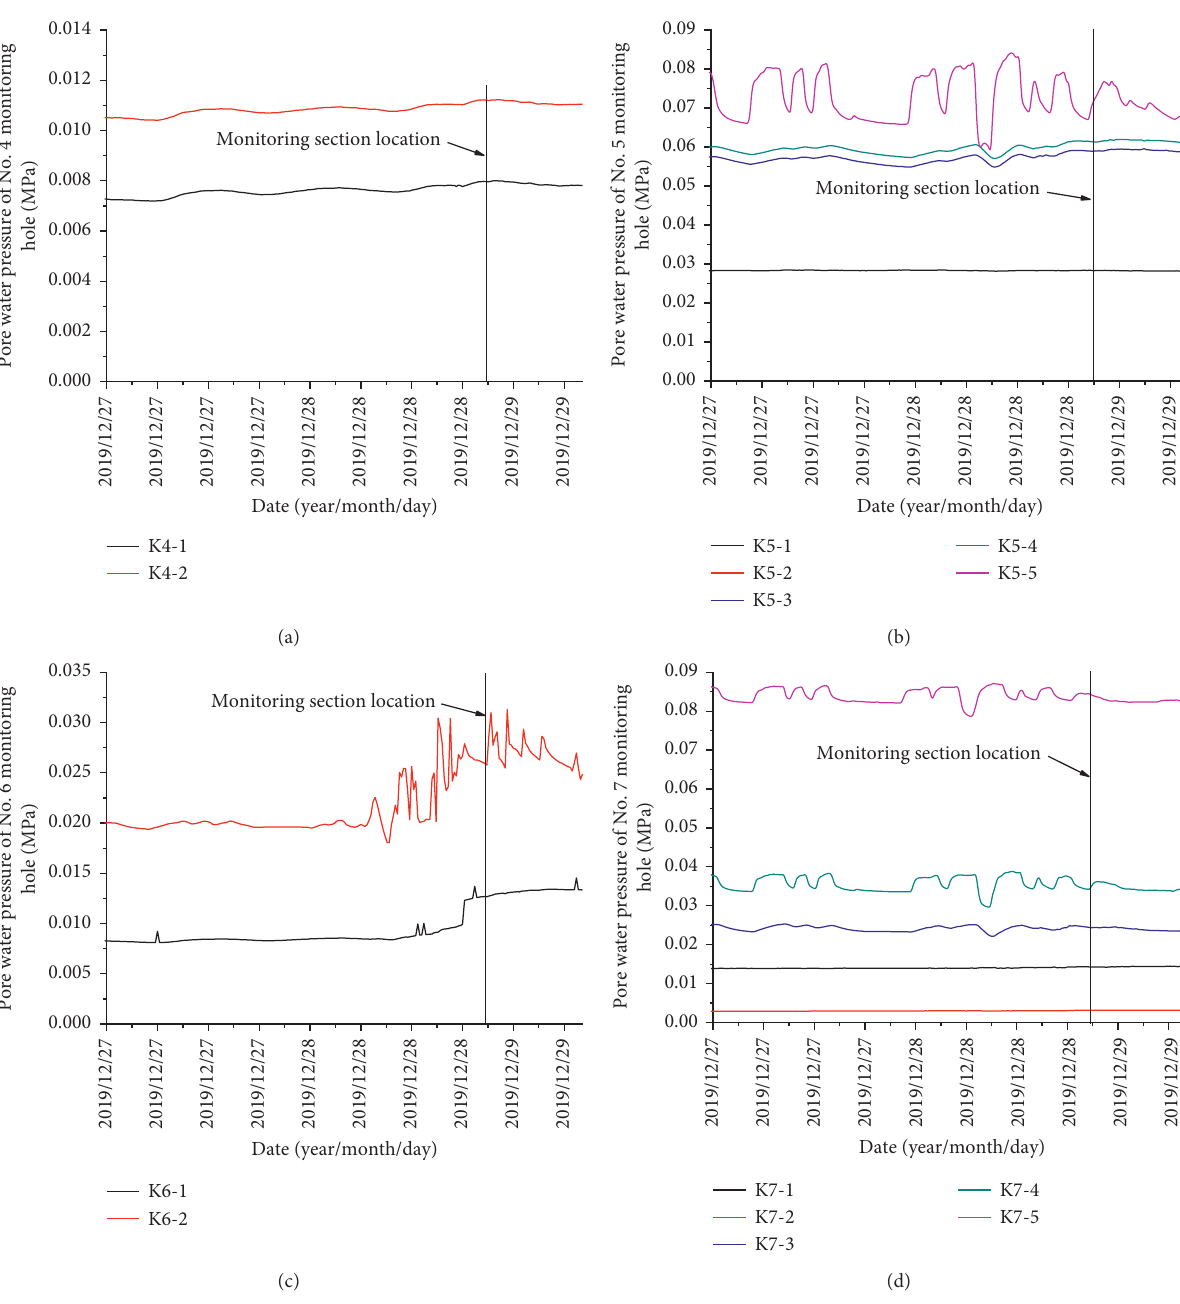
Figure 12: Variation diagram of pore water pressure during Hole 3 jacking. (a) Pore water pressure of No. 4 monitoring hole. (b) Pore water pressure of No. 5 monitoring hole. (c) Pore water pressure of No. 6 monitoring hole. (d) Pore water pressure of No. 7 monitoring